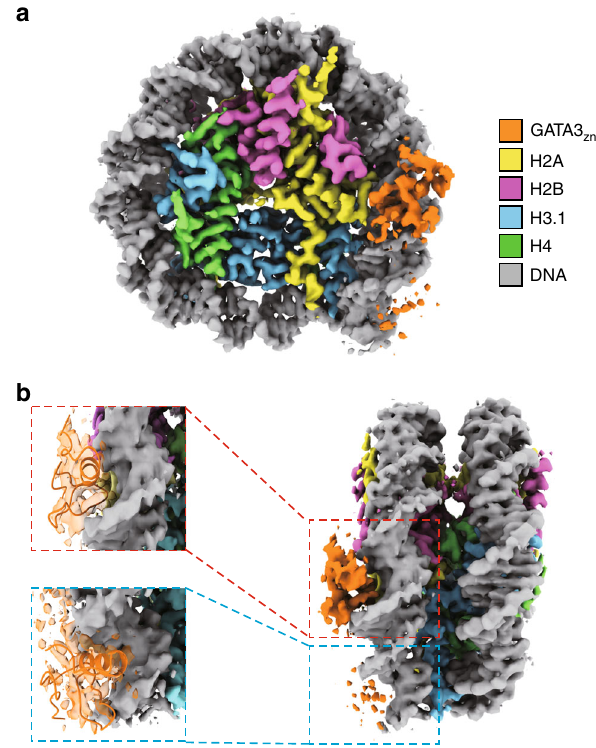
Fig. 4 Cryo-EM structure of the GATA3 znf – nucleosome complex. a Cryo- EM structure of the GATA3 znf – nucleosome complex at 3.15 Å, contoured at 3.5 σ above the mean density. b Side view of the cryo-EM structure of the GATA3 znf – nucleosome complex (right panel). A close-up view of the SHL5.5 region (dashed red box) is shown in the upper left panel. Crystal structure of the GATA3 znf C-terminal zinc fi nger (PDB ID: 4HCA) was docked into the cryo-EM density map (3.5 σ ). A close-up view of the SHL6.5 region (cyan dashed line box) is shown in the lower left panel. Crystal structure of the GATA3 znf N-terminal zinc fi nger (PDB ID: 4HCA) was docked into the cryo-EM density map (2.2 σ fi tted very well, when it is superimposed on the cryo-EM map around SHL5.5 of the GATA3 znf – nucleosome complex (Supple- mentary Fig. 6).